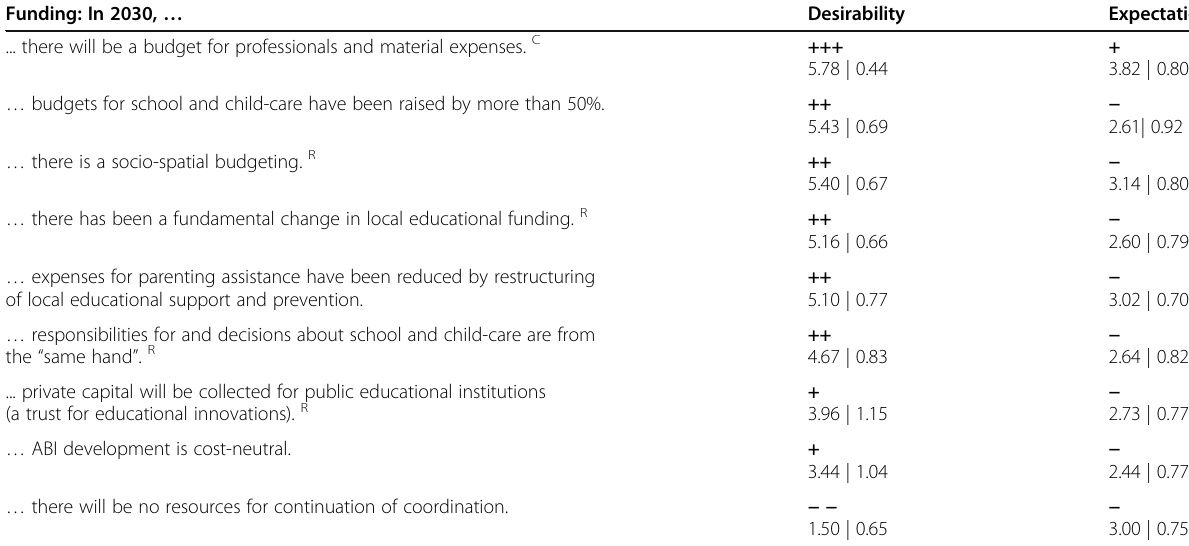
Table 9 Means and standard deviations for statements on ABI funding